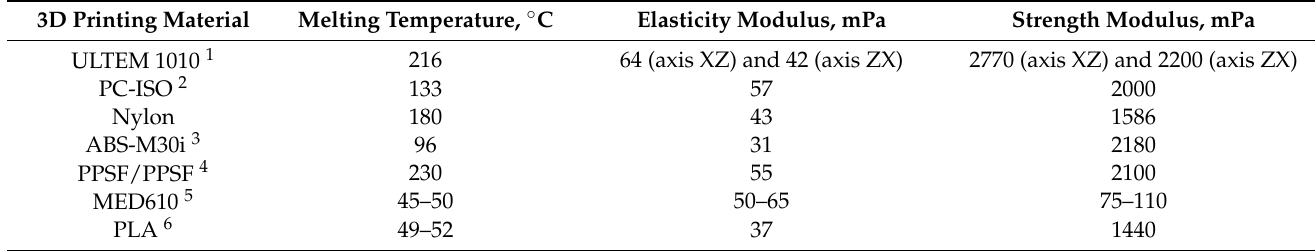
Table 2. Characteristics of materials for printing FDR half masks.